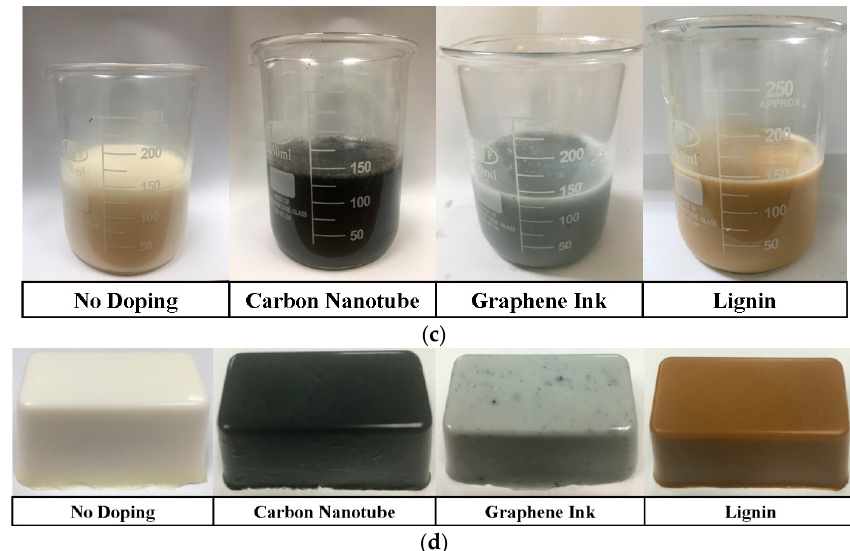
Figure 2. The variation of typical prepared and studied samples ( a ) mixed solutions; ( b ) water-gelatin mixtures; ( c ) oil-gelatin mixtures and ( d ) the solidified samples. The doping concentrations of carbon based materials are schematically chosen as 6 wt %.